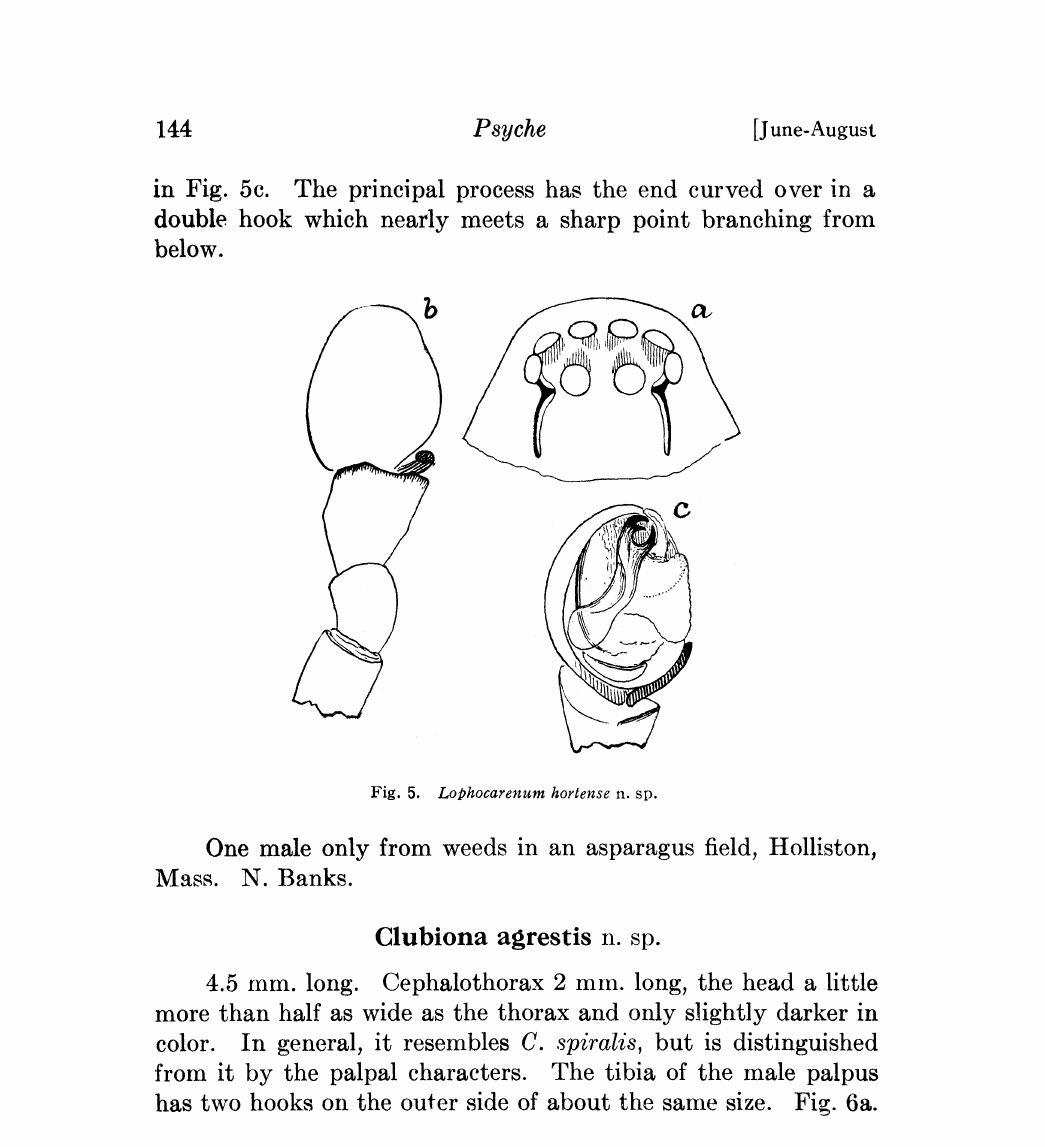
Fig. 5. Lophocarenum hortense